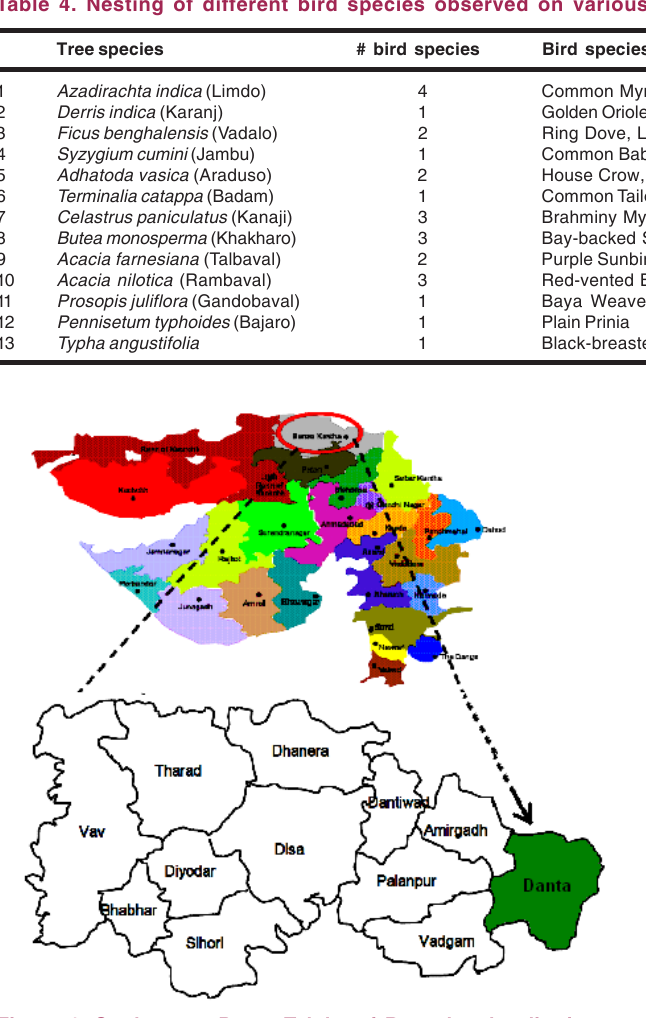
Figure 1. Study area: Danta Taluka of Banaskantha district, Gujarat